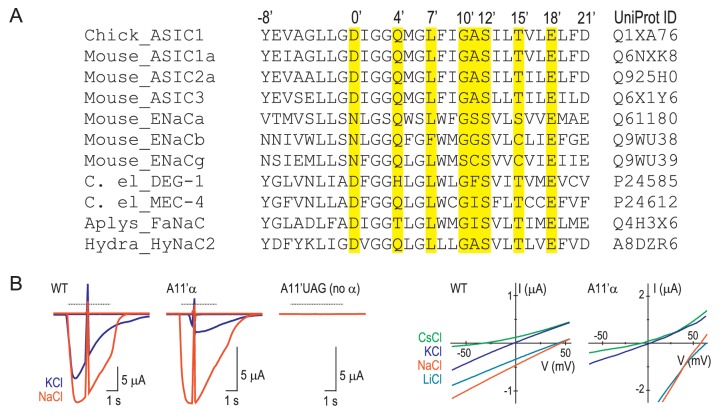
Numbering scheme for M2 residues.(A) Referring to molecular determinants of function in the ENaC/DEG family with amino acid numbers of various channels makes comparisons confusing. E.g. it is not immediately clear that ENaC α subunit (species not reported) S589 (Waldmann et al., 1995) and rat ENaC (rENaC) α subunit S589 (Kellenberger et al., 1999a) mutations, both of which alter ion selectivity in those studies, actually refer to adjacent positions (GSS and GSS, respectively). Similarly, it is not immediately clear that A443 in mouse ASIC1a (mASIC1a) (Carattino and Della Vecchia, 2012), A444 in human ASIC1a (hASIC1a) (Yang et al., 2009) and G530 in rENaC β, (Kellenberger et al., 1999b) each of which determine ion permeability to some extent, actually occupy the equivalent position. To avoid such confusion, we have adopted a new numbering system, based on various functional data, recent structural data and the comparison of a diverse range of subunits from the family (similar to the numbering systems for pore-lining residues in Cys-loop receptors or S4 charges in voltage-gated ion channels). According to this analysis, the equivalent residues, D434 that contributes to ion permeation in hASIC1a (Yang and Palmer, 2014), D433 whose side chain is oriented into the top of the channel pore of chick ASIC1 (Baconguis et al., 2014), and D431 that contributes to Ca2+ permeability in HyNaC2 (Dürrnagel et al., 2012), are simply referred to as D0’. mASIC1a A443, hASIC1a A444 and rENaC β G530 (described above), are equivalent and now referred to as A11’, A11’ and G11’, respectively. The amino acid sequence alignment (Edgar, 2004) in (A) details the prime numbering system. Yellow highlighting indicates residues whose mutation is reported to alter channel function in at least two family members, as follows. 0’: lamprey ASIC1 D433N alters gating (Li et al., 2011a); hASIC1a D434N decreases ion conduction (Yang and Palmer, 2014); hydra HyNaC D431C decreases Ca2+ permeability (Dürrnagel et al., 2012). 4’: lamprey ASIC1 Q437C is water-accessible (Li et al., 2011b); chick ASIC1 Q437A slows desensitization (Baconguis et al., 2014). 7’: hASIC1a L440A decreases Na+/K+ selectivity (Yang et al., 2009); lamprey ASIC1 L440C is water-accessible (Li et al., 2011b); mASIC1a L439A decreases Na+/K+ selectivity (present study). 10’: rENaC β G529S decreases Na+/K+ selectivity (Kellenberger et al., 1999b); mENaC α G587C decreases Na+/K+ selectivity (Sheng et al., 2000). 11’: ENaC α S589I alters gating and Na+ conduction (species not reported [Waldmann et al., 1995]); hASIC1a A444G decreases Na+/K+ selectivity (Yang et al., 2009). 12’: C. elegans MEC-4 S455F decreases function (Hong and Driscoll, 1994); rENaC α S589C/D decreases Na+/K+ selectivity (Kellenberger et al., 1999a). 15’: C. elegans MEC-4 T458I decreases function (Waldmann et al., 1995); ENaC α S593I alters gating (species not reported (Waldmann et al., 1995); mASIC1a T447V prevents functional expression (Figure 4—figure supplement 1). 18’: C. elegans MEC-4 E461K decreases function (Hong and Driscoll, 1994); mENaC α E595C decreases Na+/K+ selectivity (Sheng et al., 2001); mASIC1a E450D/Q decreases Na+/K+ selectivity (present study). (B) Left, voltage ramps at rest and during activation of currents by pH 6.0 (dashed line) in different extracellular cations (indicated by color) at oocytes injected with WT mRNA, A11’UAG mRNA + tRNA-α, or A11’UAG mRNA + tRNA (the latter as a measure of non-specific incorporation). Right, current-voltage relationships of proton-gated current, where ramp during rest has been subtracted.